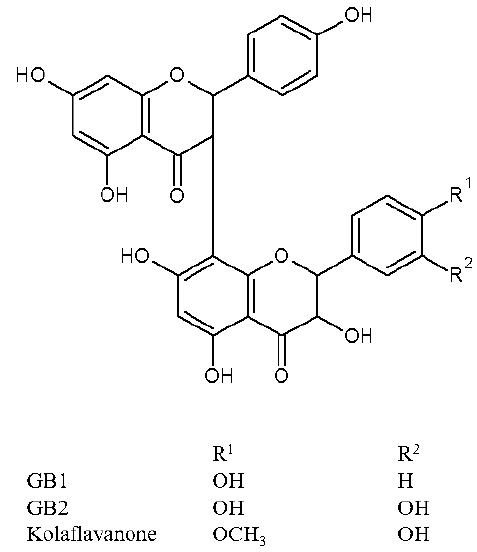
Figure 3. Biflavonoid complex kolaviron and its components.